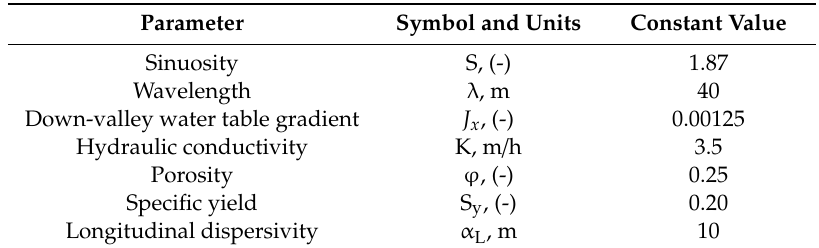
Table 1. Constant values for major geomorphic and aquifer parameters. Parameter